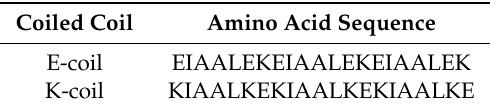
Table 1. Amino acid sequences of E- and K-coil.